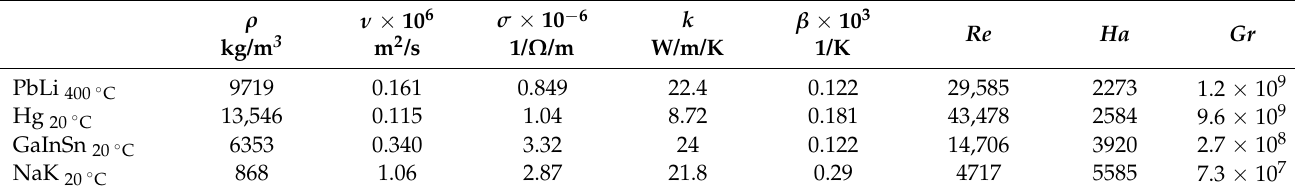
Table 2. Thermophysical properties of PbLi at 400 ◦ C and examples of possible model fluids that allow experimentation at room temperature. Nondimensional parameters have been evaluated for experimental conditions with B exp = 2 T, L exp = 0.05 m and u 0 = 0.1 m/s. For the Grashof number Gr a wall heat flux of 10 W/cm 2 is